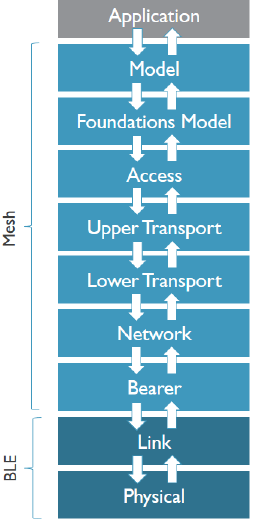
Figure 3. BLE mesh